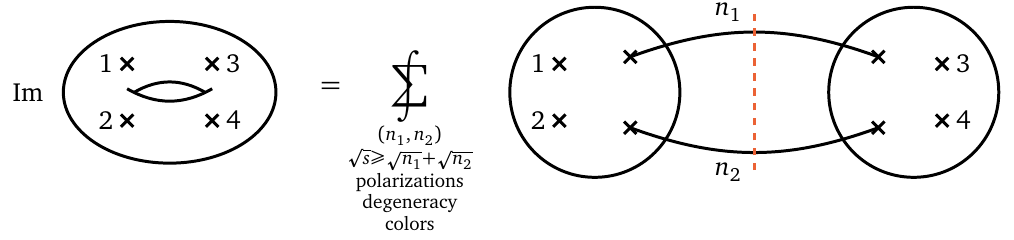
Figure 2: Imaginary parts of genus-one four-point amplitudes in the s -channel come entirely from the normal thresholds at s ⩾ ( ( n ) labels the mass squares of the intermediate states. In this work we show how , n 1 2 the integration contours from Figure 1, for either open or closed strings, reproduce unitarity cuts without the need for laborious sums over the intermediate